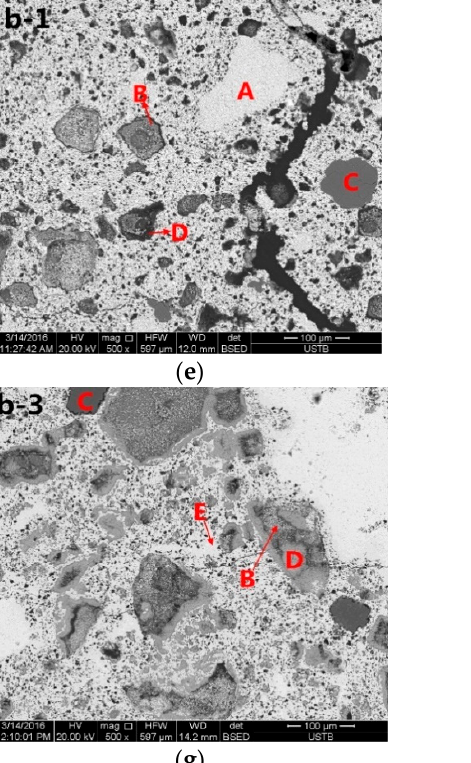
2 O 3 in standard PDF